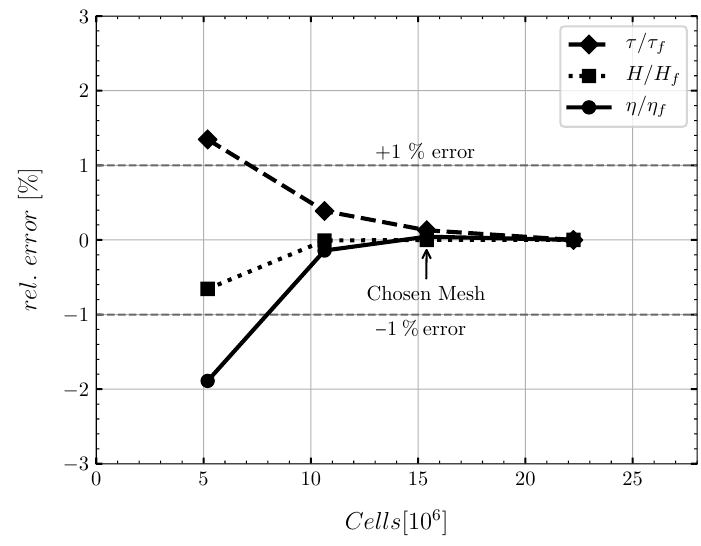
Figure 3. Grid convergence analysis results for Case